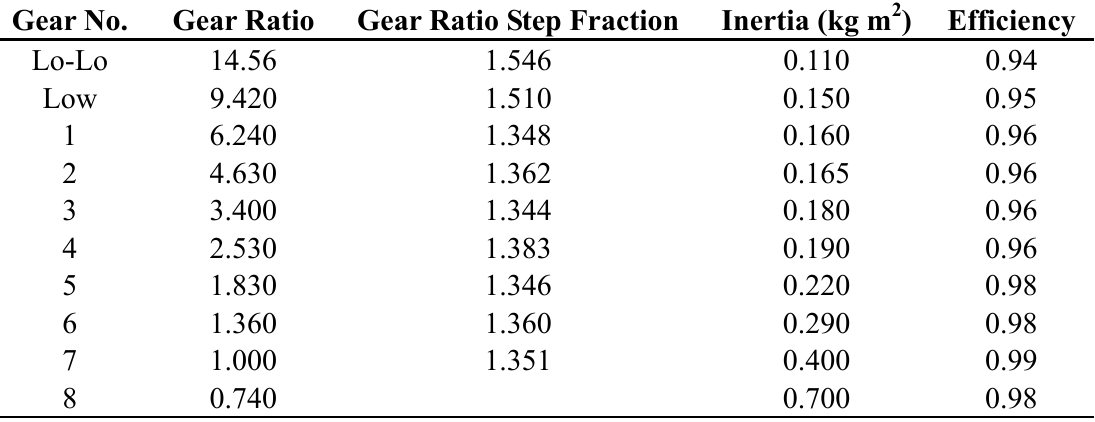
Table 4. Data of two AMTs. ( a ) Gear ratio and efficiency of 10-speed AMT; ( b ) Optimal shift schedule of 10-speed AMT; ( c ) Gear ratio and efficiency of 12-speed AMT; ( d ) Optimal shift schedule of 12-speed AMT. Gear